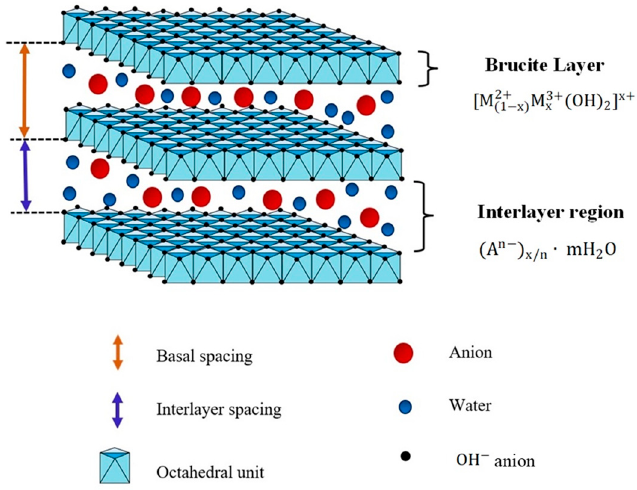
Figure 1. Structural scheme for hydrotalcite materials. Adapted from H Kaur et al. [5]. LDHs have been employed as heterogeneous photocatalysts in the absorption of pharmaceutical compounds, pollutants photodegradation [6], water splitting [7], and chromium reduction [8], among